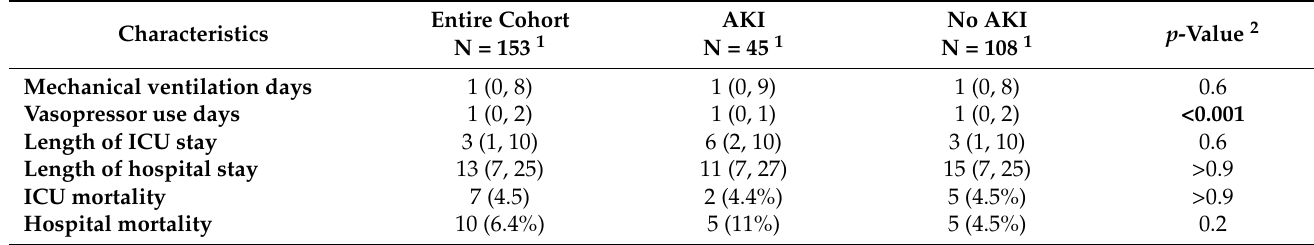
Table 4. Patient outcomes in the overall population and according to